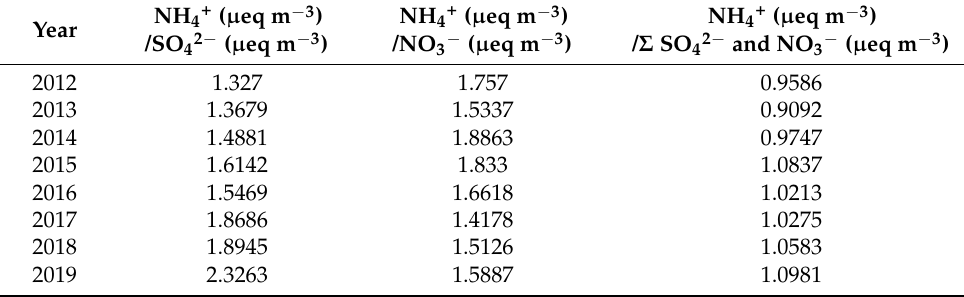
Figure 10. Changes in the SOR and NOR according to PM2.5 concentration on Baengnyeong Island: ( a ) SOR; ( b ) NOR. Table 4. The annual equivalent ratio in